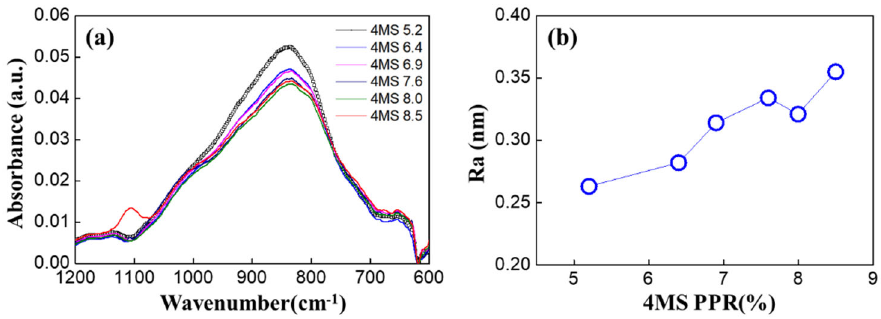
Figure 8. Results of ( a ) FT ‐ IR and ( b ) AFM according to 4MS PPR.